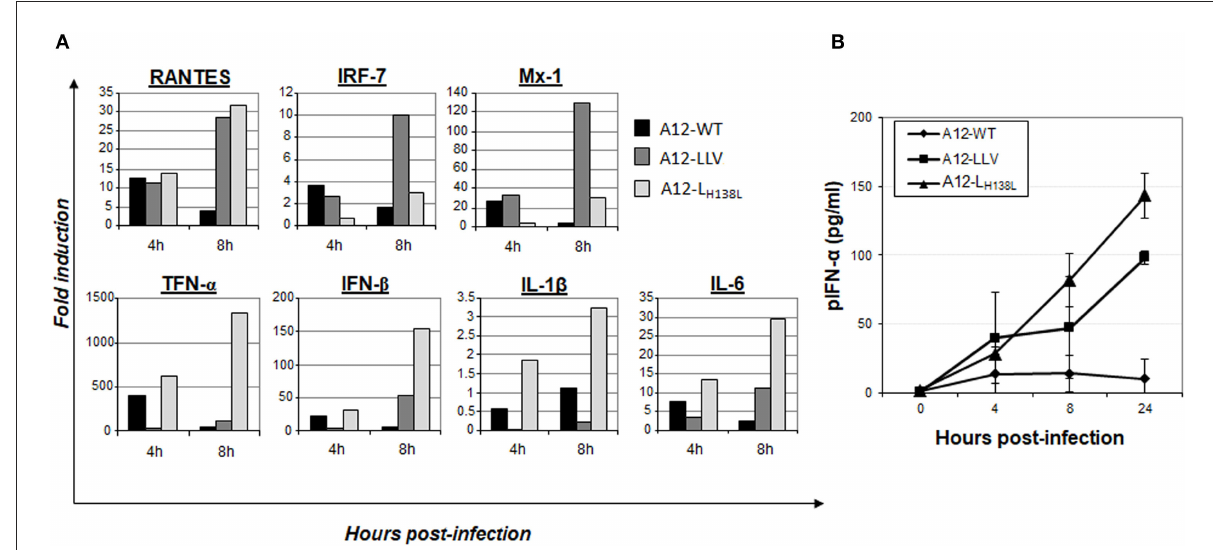
FIGURE5 Induction of IFN and ISGs during infection. (A) Expression of IFN- β , TNF- α , RANTES, Mx1, IL-1 β and IL-6 and IRF7 mRNAs was measured by real-time RT-PCR in primary porcine kidney cells infected with A12-WT, A12-LLV and A12-L H138L at MOI = 10. Graphs represent results of one out three independent studies with parallel results. (B) Porcine IFN α ELISA in supernatants of PK cells infected with A12-WT, A12-LLV and A12-L H138L, plotted as AVER ± . STDEV of three independent